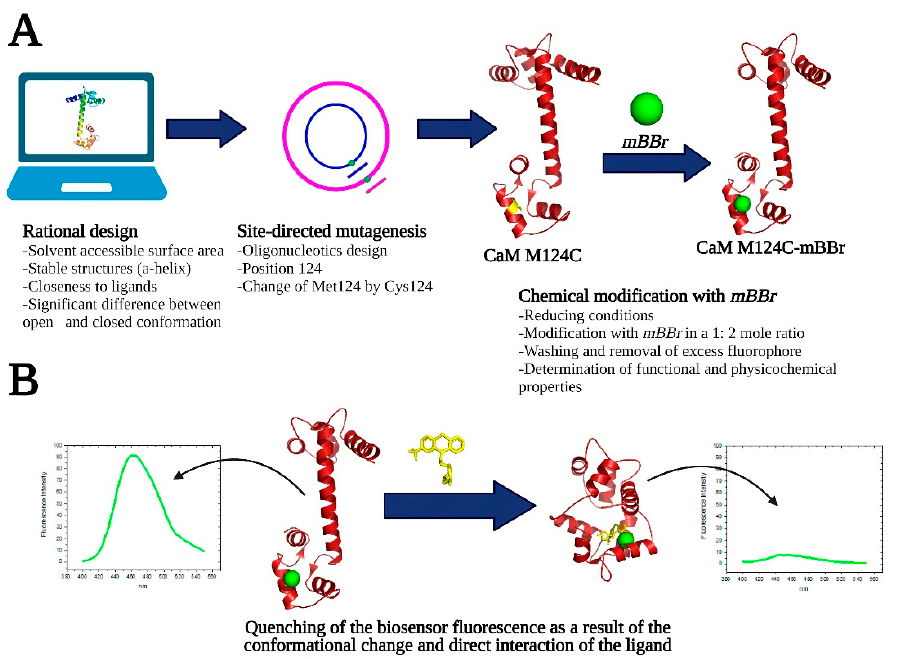
Figure 1. Development and functionality of the h CaM-M124C- mBBr biosensor. Panel ( A ) shows the complete development for the construction of the fluoresce biosensor, highlighting the critical points of each step of the process. Panel ( B ) presents the functionality of this development, where the change of the microenvironment and direct interaction of the ligand turns off the fluorophore.